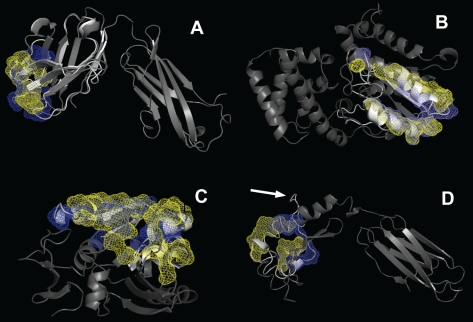
Examples of partial homology models.The models (white ribbons) are superimposed on the target native structures (gray ribbons). (A) Good accuracy model (interface RMSD = 5.0 Å) in the case of target and template proteins from the same organism. Target is malaria transmission blocking antibody 2A8 from mouse, (1z3g, chain H) and template is mouse BM3.3 T-cell receptor α-chain (1fo0, chain A). (B) Good accuracy model (interface RMSD = 3.7 Å) in the case of target and template proteins from different organisms. Target is guanine nucleotide-binding protein alpa-1 subunit from bovine, (1fqj, chain A) and template is yeast RAS-related protein RAB-33 (2g77, chain B). (C) Acceptable accuracy model (interface RMSD = 8.6 Å). Target is fibrillarin-like preRRNA processing protein from Archaeoglobus fulgidus (1nt2, chain A) and template is UDP-N-acetylglucosamine 4-epimerase from Pseudomonas aeruginosa (1sb8, chain A). (D) Incorrect model (interface RMSD = 16.9 Å). Target is human MHC Class II receptor HLA-DR1 (1kg0, chain B) and template is intron-encoded endonuclease from Desulfurococcus mobilis (1b24, chain A). Arrow indicates an incorrect loop which is the cause for large interface RMSD in this model. Blue and yellow meshes indicate positions of the backbone atoms of the interface residues in the model and the native structures, respectively. Other parameters of the models are presented in Table 3.